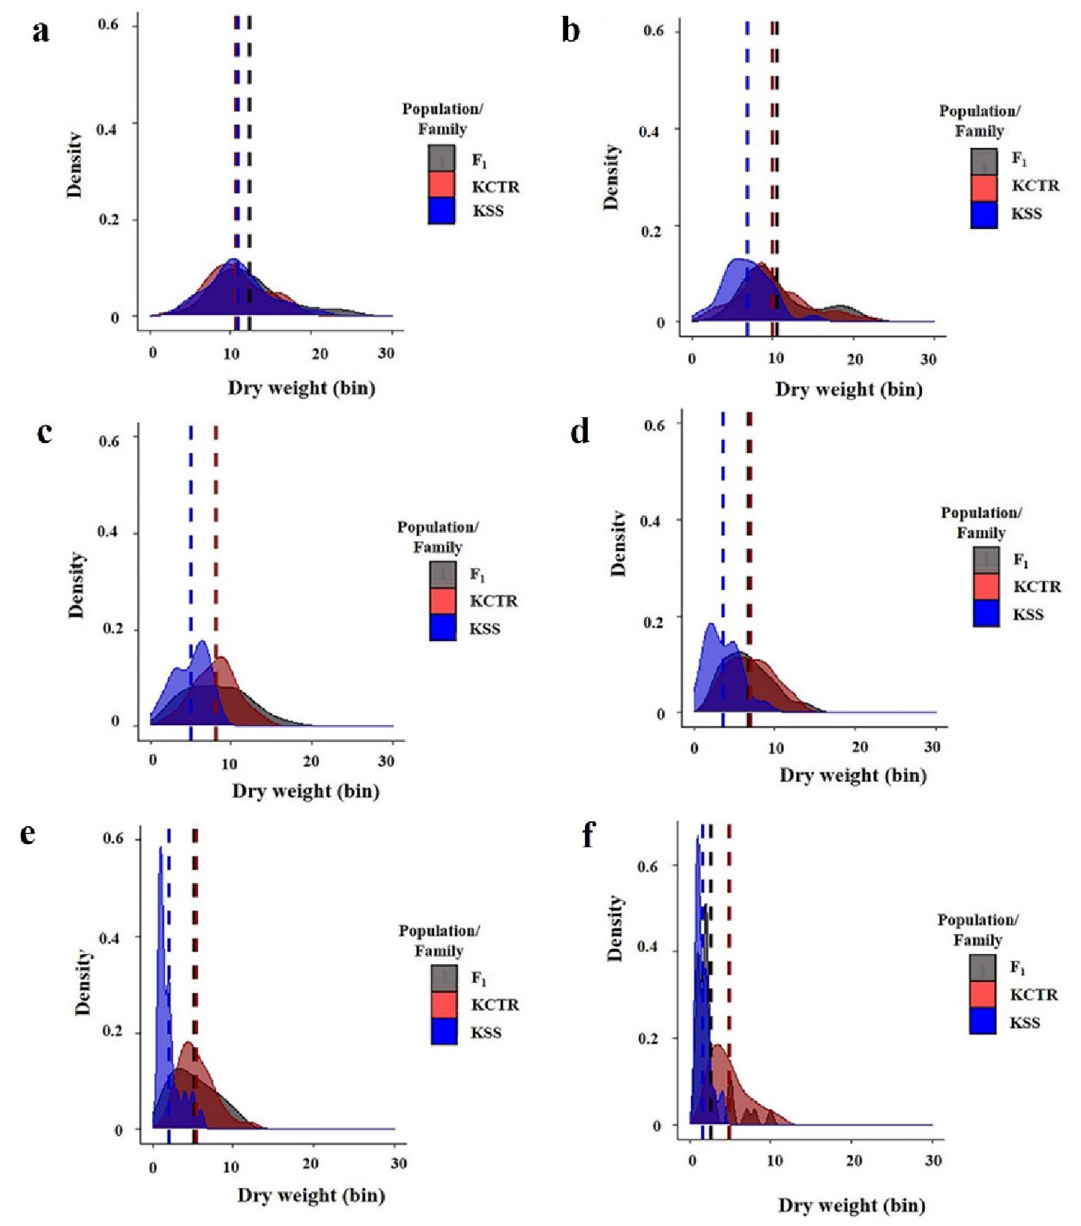
Figure 2. Cumulative dry weight distribution of 2,4-D susceptible (KSS), resistant (KCTR), Palmer amaranth and F 1 progenies in response to 2,4-D at ( a ) 0 (non-treated) ( b ) 140, ( c ) 280, ( d ) 560 (field recommended dose), ( e ) 1120, and ( f ) 2240 g ae ha −1 via density plots. Dry weight of samples was converted into bins and plotted in the X-axis. Y-axis was plotted by calculating density which is the proportion of total plants in each bin. Dotted lines represent mean dry weight of KSS, KCTR, and F 1